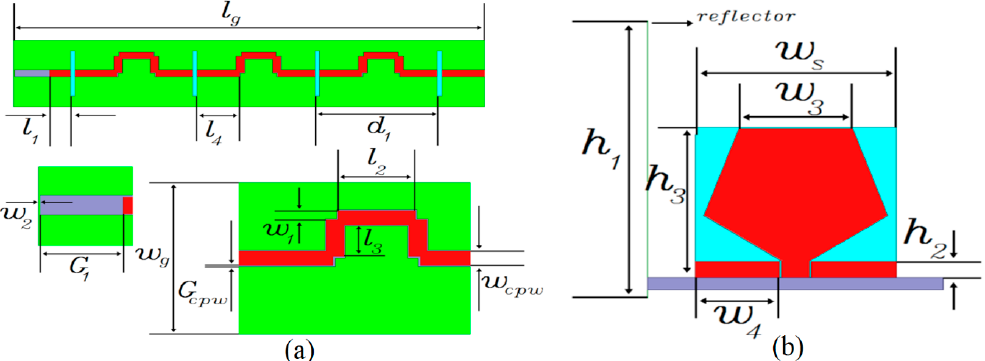
Figure 3. ( a ) CPW feed line; ( b ) Geometrical parameters of the developed single element of the fan beam array.